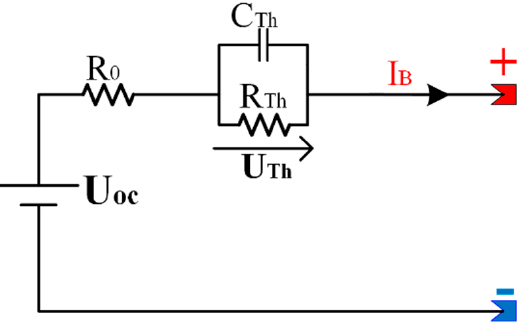
Figure 2. Equivalent circuit of Li-ion battery Model.